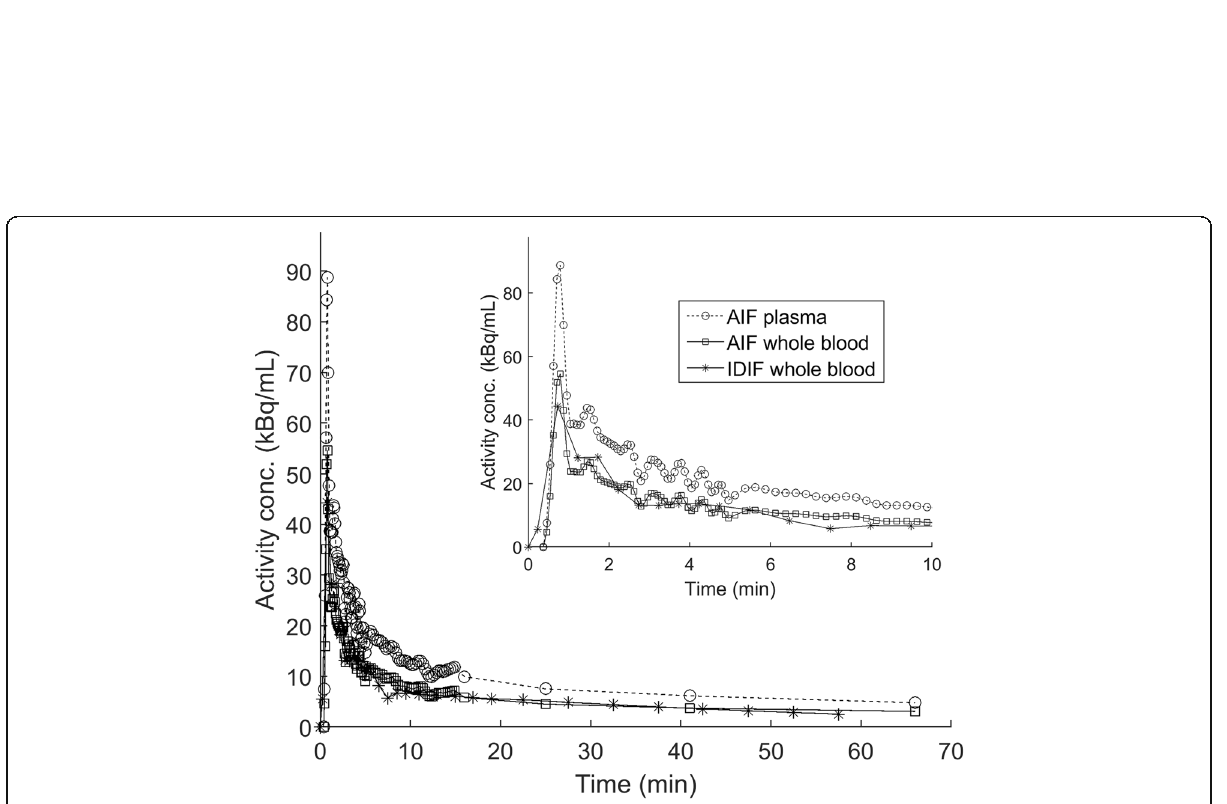
Fig. 3 Radiochromatograms from metabolite analysis by UHPLC. Standard solution of 68 Ga-PSMA-11 with a retention time of 5.1 min ( a ). 68 Ga- PSMA-11 incubated in plasma in vitro, showing a single peak at 5.1 min ( b ). Patient plasma sample showing a single peak, slightly delayed due to tubing to collect UHPLC fractions (fractions collected every 20 s and subsequently counted in gamma counter) ( c )